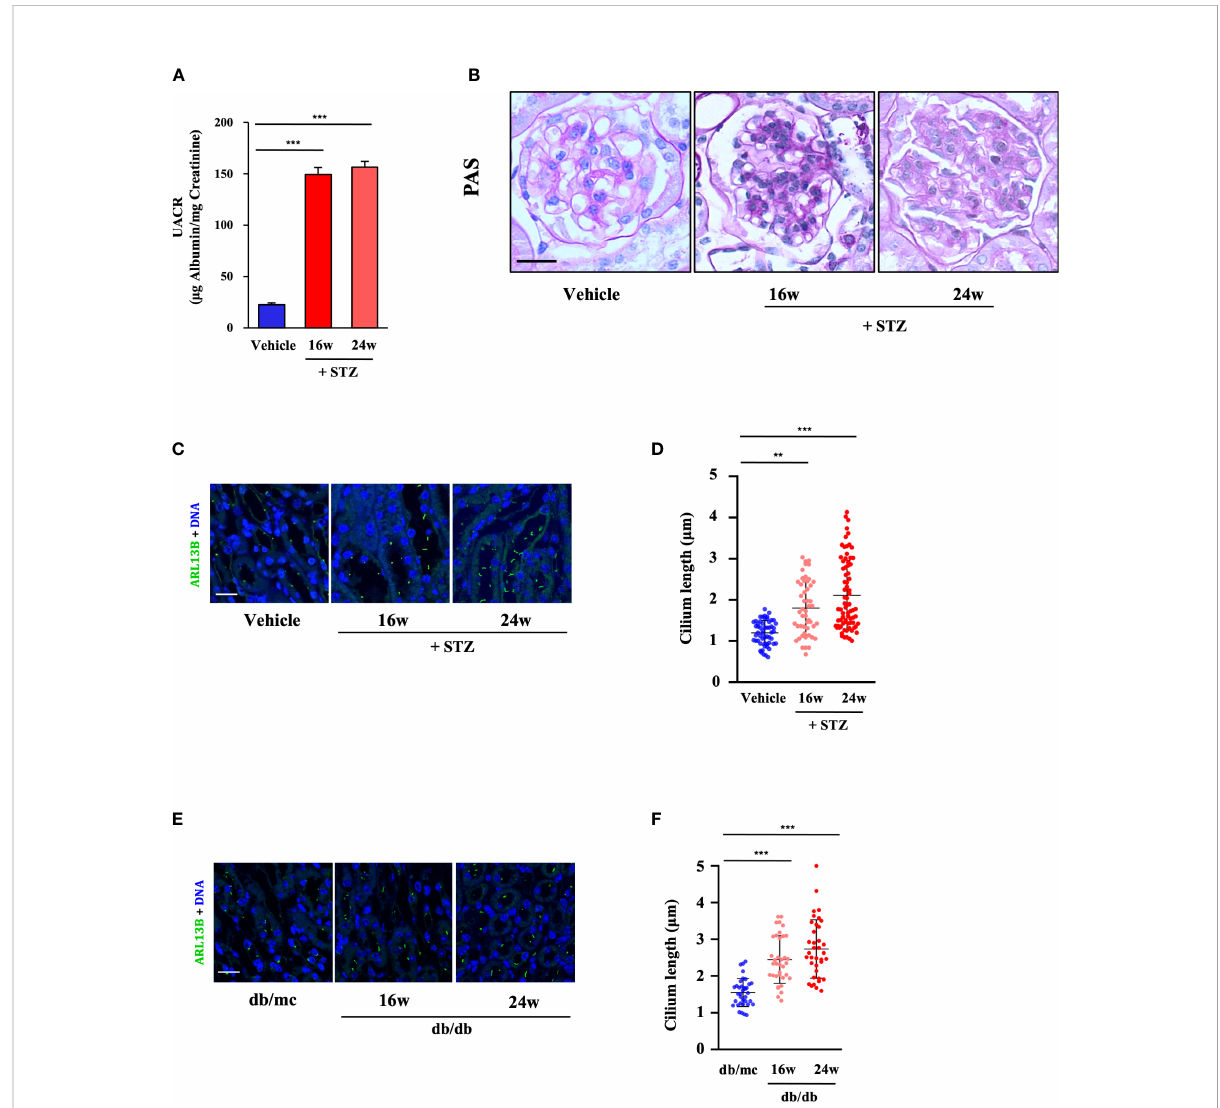
FIGURE 2 Renal cilia were lengthened in two different diabetic mouse models. (A) Urinary albumin-to-creatinine ratio (UACR) at 0, 16, and 24 weeks post-STZ injection (four mice per group). (B) Kidney sections from STZ-induced diabetic mice at 0, 16, and 24 weeks post-STZ injection were stained with PAS. Scale bar, 20 m m. (C) Kidney sections from STZ-induced diabetic mice were stained for the ciliary marker ARL13B (green) and DNA (blue). Scale bar, 20 m m. (D) Quanti fi cation of the cilium length in (C) (four mice per group). (E) Kidney sections from db/db mice were stained for the ciliary marker ARL13B (green) and DNA (blue). Scale bar, 20 m m. (F) Quanti fi cation of the cilium length in (E) (four mice per group). Each dot represents one cell. The data are the means ± SD. One-way ANOVA was performed followed by Dunnett ’ s multiple comparisons. ** P < 0.01; *** P <